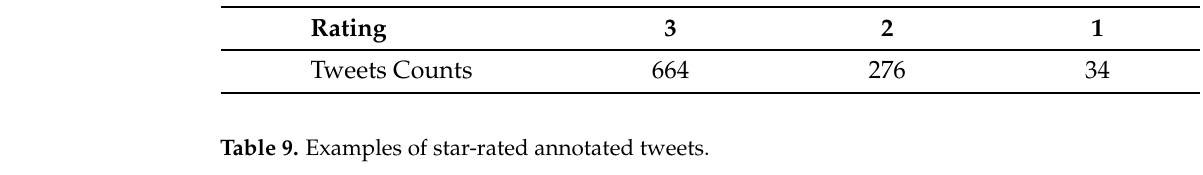
Table 8. Annotation summary—3 scale range.